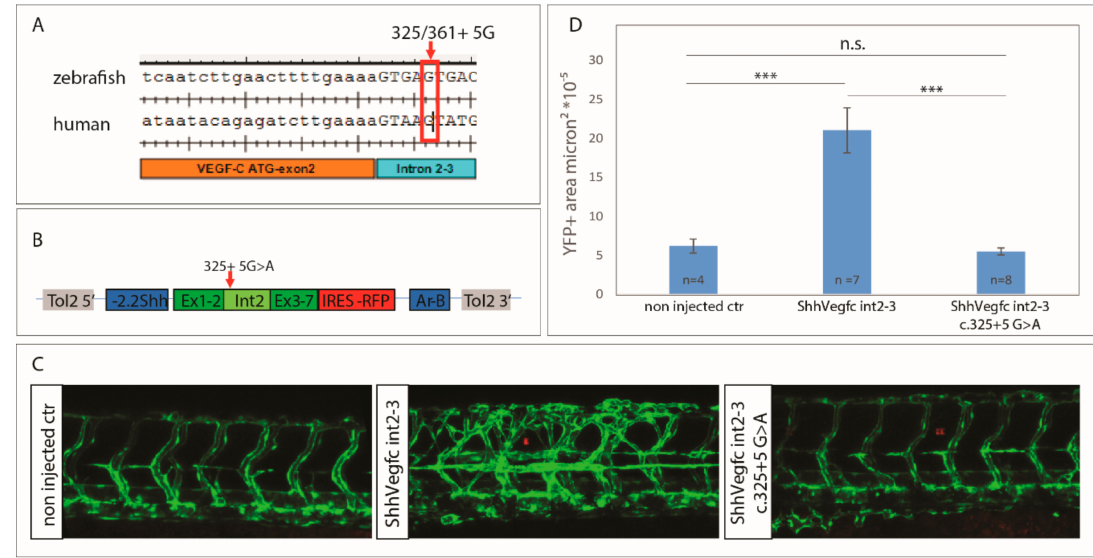
Figure 3. Splice site mutation c.325+5G>A in vegfc abolishes the effect of ectopic expression on excessive vessel sprouting. ( A ) Sequence of the human and zebrafish VEGFC/vegfc orthologs. Alignment of zebrafish and human exon 2 and intron 2–3 highlights the mutated site c.361+5G, which is equivalent to zebrafish c.325+5G. ( B ) Diagram of constructs used for forced expression of either vegfc-intron2–3